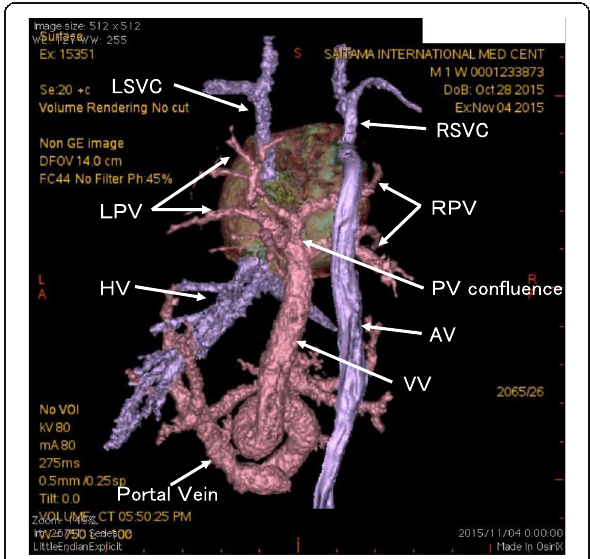
Fig. 1 Computed tomography angiography shows that the vertical vein from pulmonary venous confluence goes through the diaphragm and drains into the portal vein, winding its way like a spiral. LSVC left superior vena cava, RSVC right superior vena cava, LPV left pulmonary vein, RPV right pulmonary vein, HV hepatic vein, AV azygous vein, VV vertical